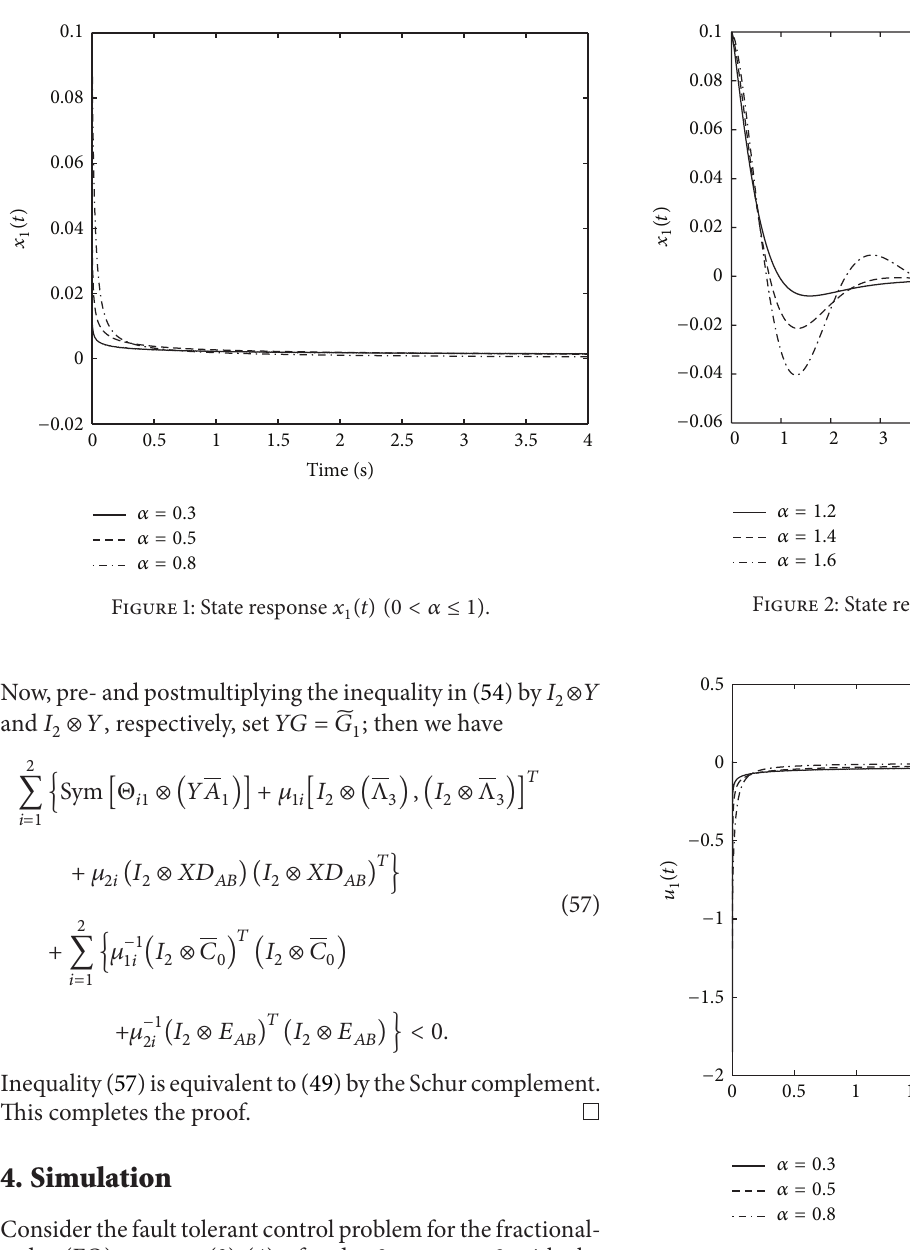
Figure 3: Control input 𝑢 1 (𝑡) (0 < 𝛼 ≤ 1)